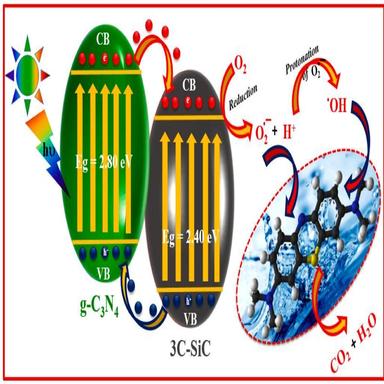
Proposed mechanism for photocatalytic degradation of MB dye using 3C–SiC@g-C3N4 nanocomposite under visible light irradiations.